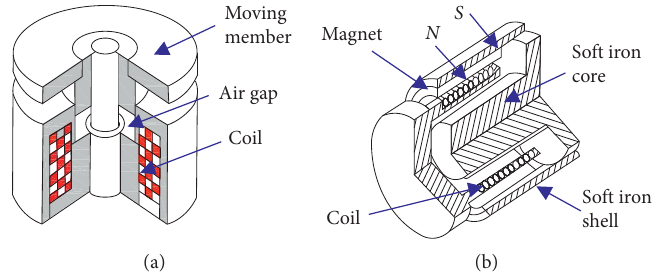
Figure 2: Electromagnetic actuators [50]: (a) solenoid; (b) voice coil actuator.